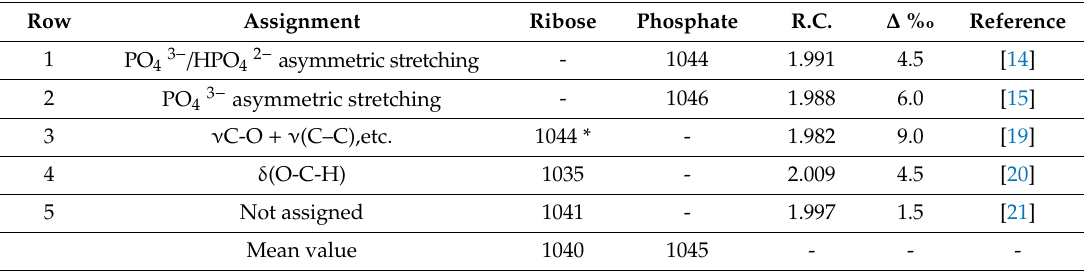
Table 6. Vibrational data for phosphates and